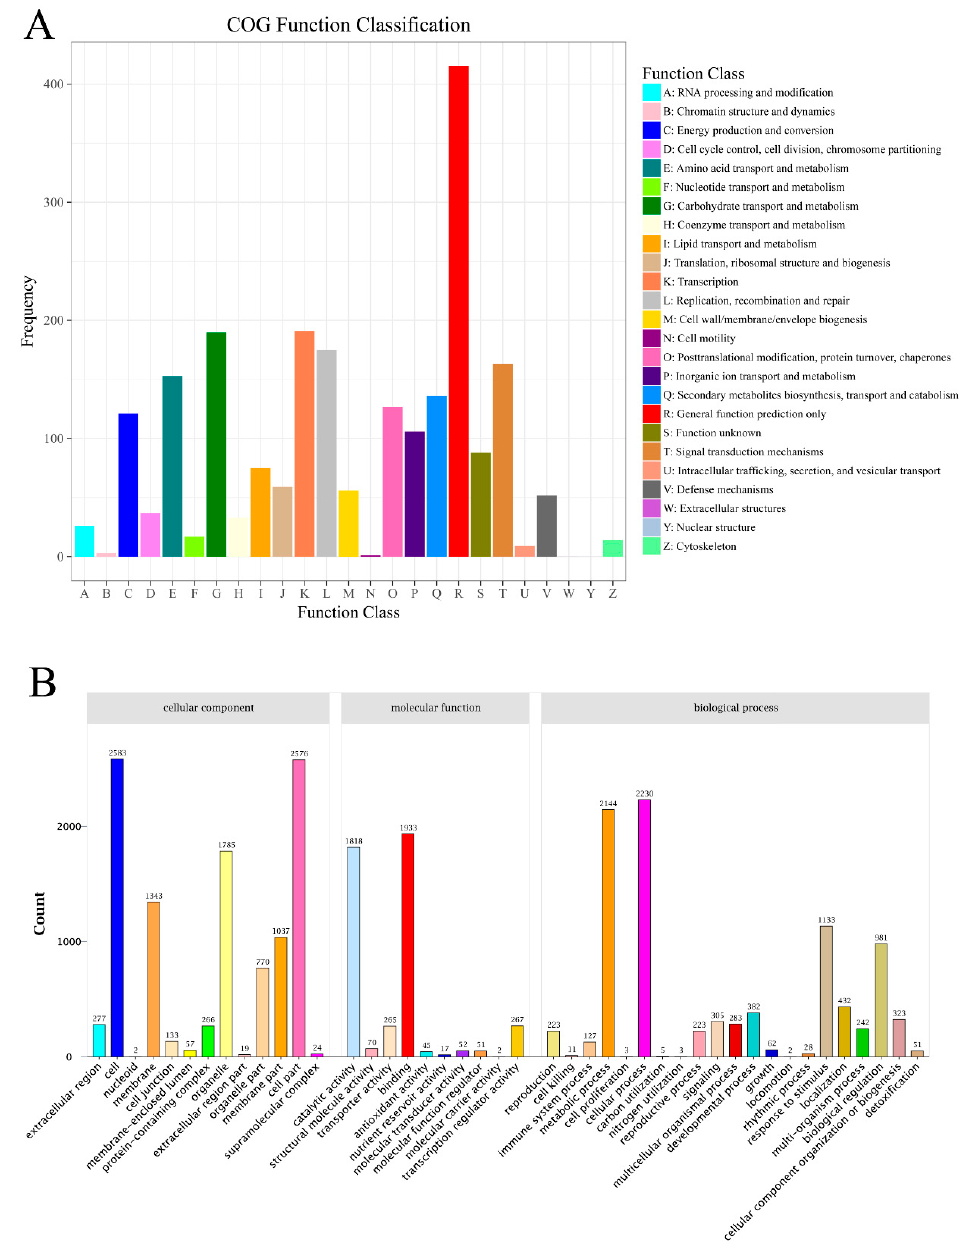
Figure 2. Functional annotation of differentially expressed genes of pecan in the comparison of AL vs. GL. ( A ): COG classification. ( B ): GO classification. Table 2. Summary of functional annotation of the differentially expressed genes.